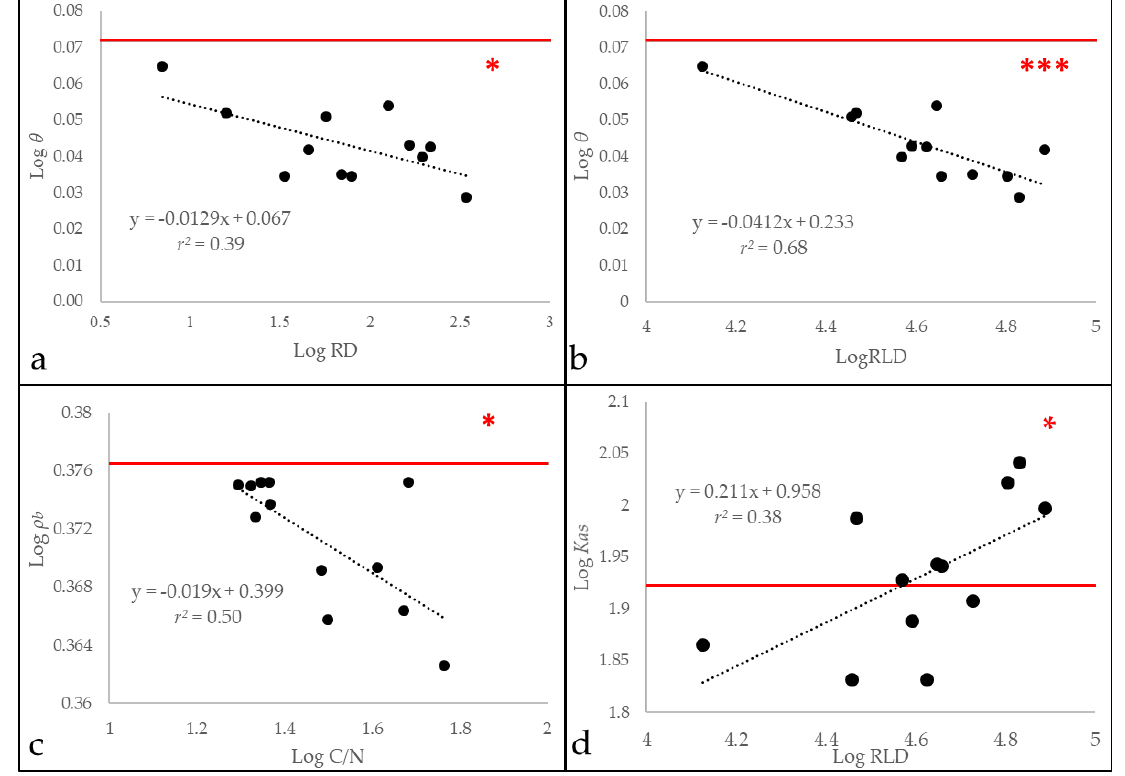
DMC = Dry Matter Content.